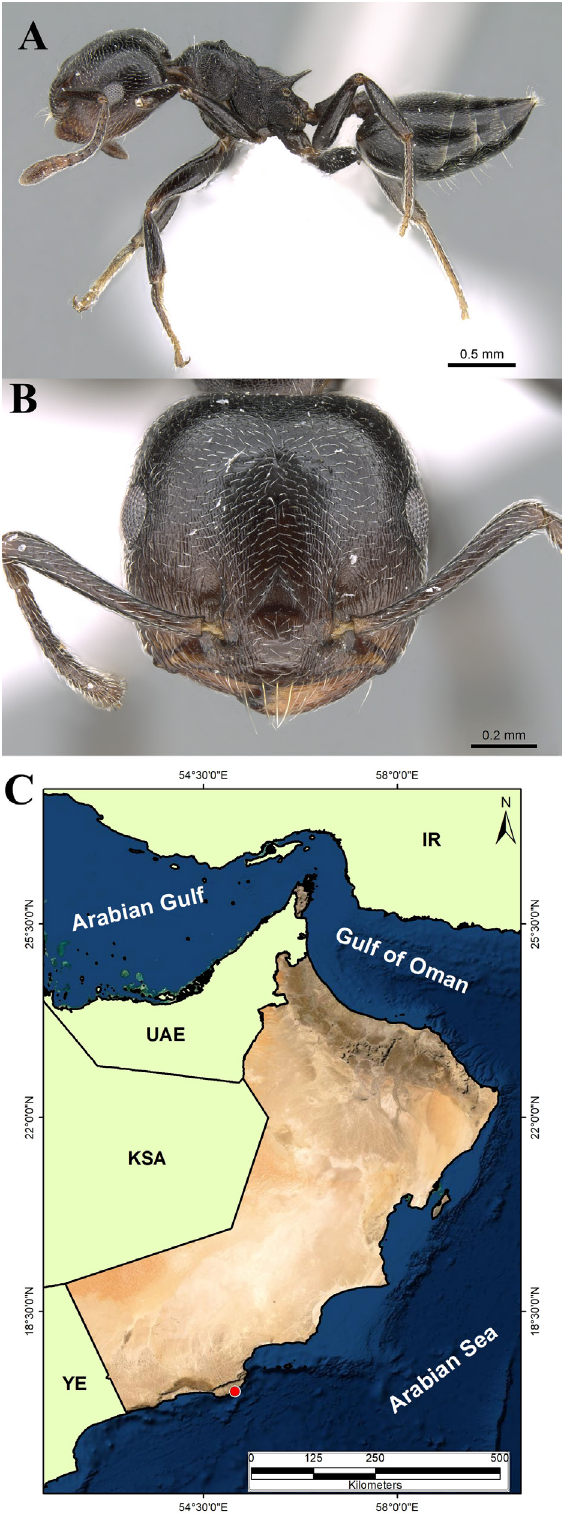
Fig. 31. Crematogaster chiarinii Emery, 1881, worker (CASENT0906369, AntWeb.org (Estella Ortega)). A . Body in profile. B . Head in full-face view. C . Distribution